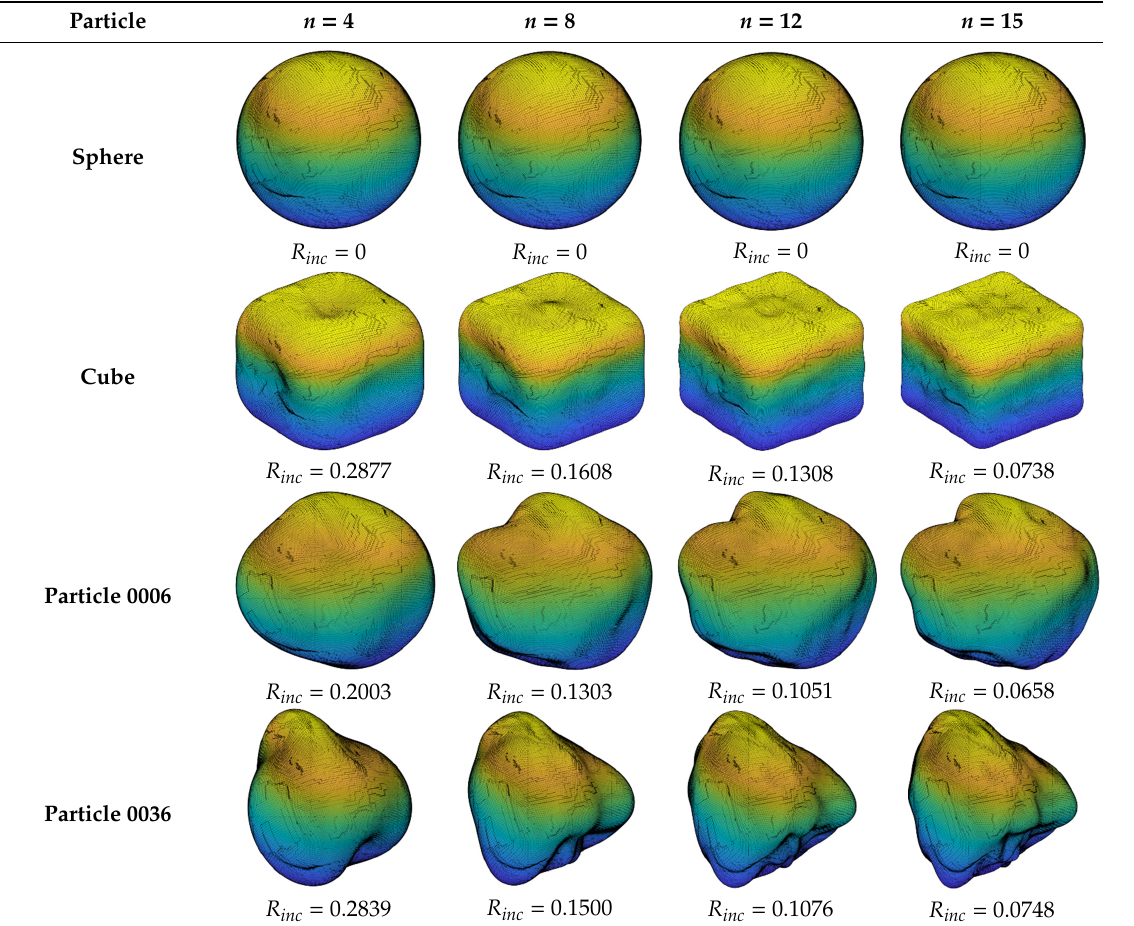
Table 2. Variation of R inc with SH decomposition.